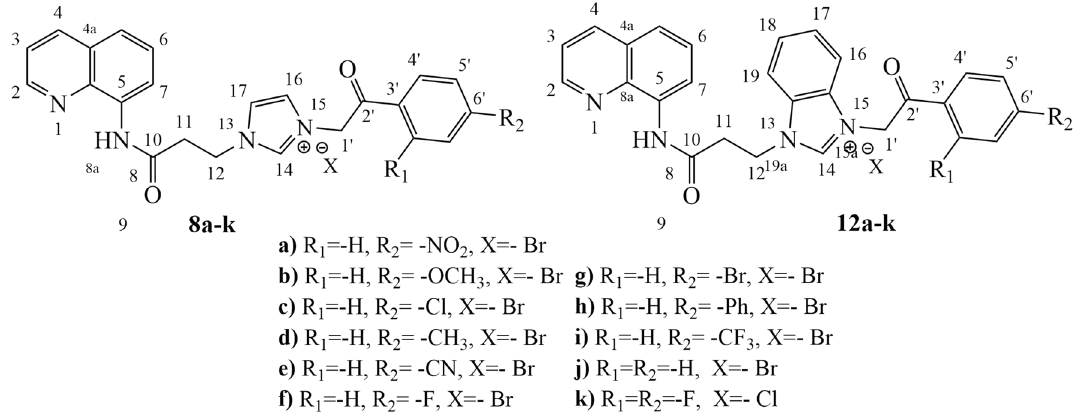
Figure 5. The number of atoms attributed to quaternary salts 8a–k and 12a–k